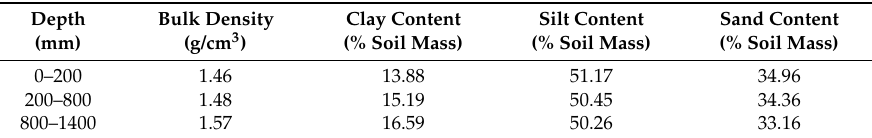
Table 2. Selected soil parameters and values used in SIMDualKc model.